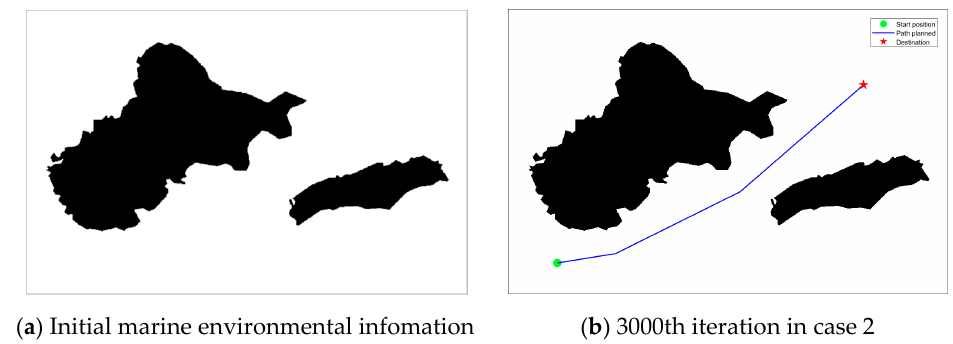
Figure 10. Path planning results in case 2 of marine environment. ( a ) Initial marine environmental information; ( b ) 3000th iteration in case 2.